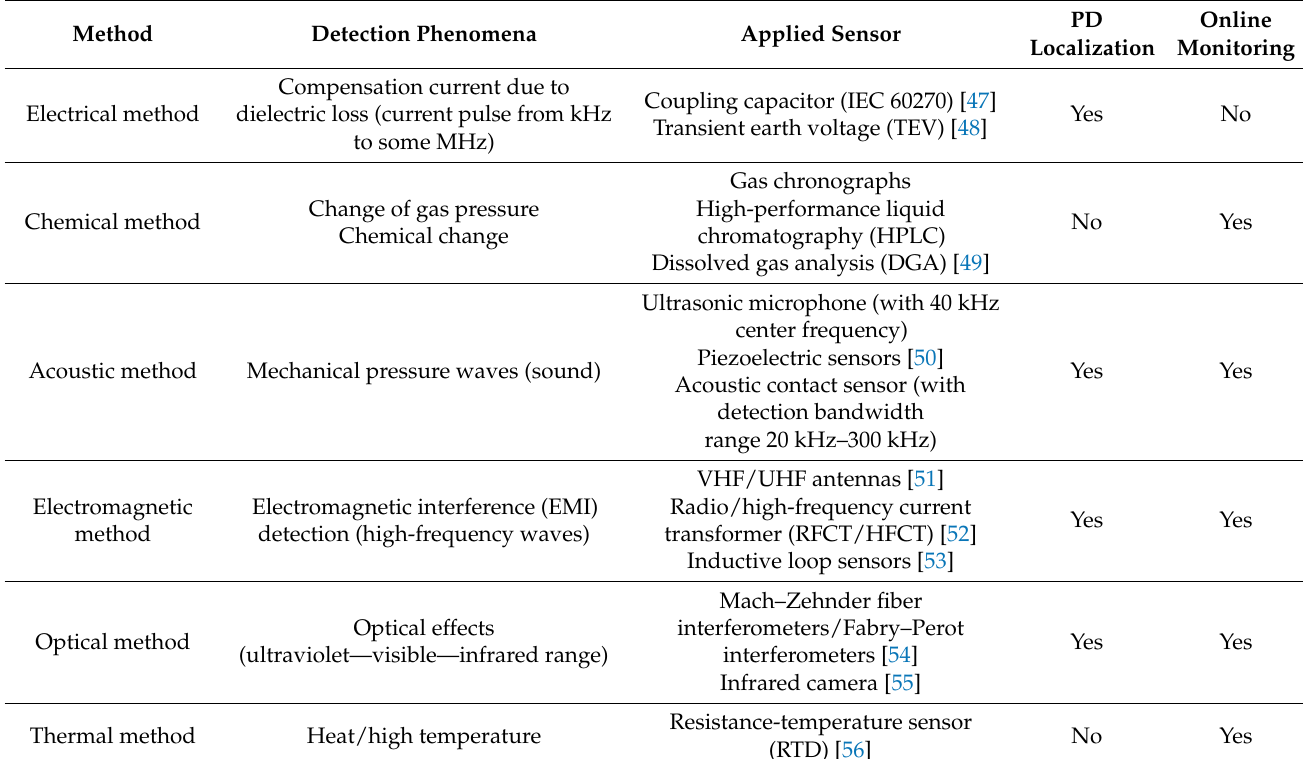
Table 1. Most common partial discharge detection